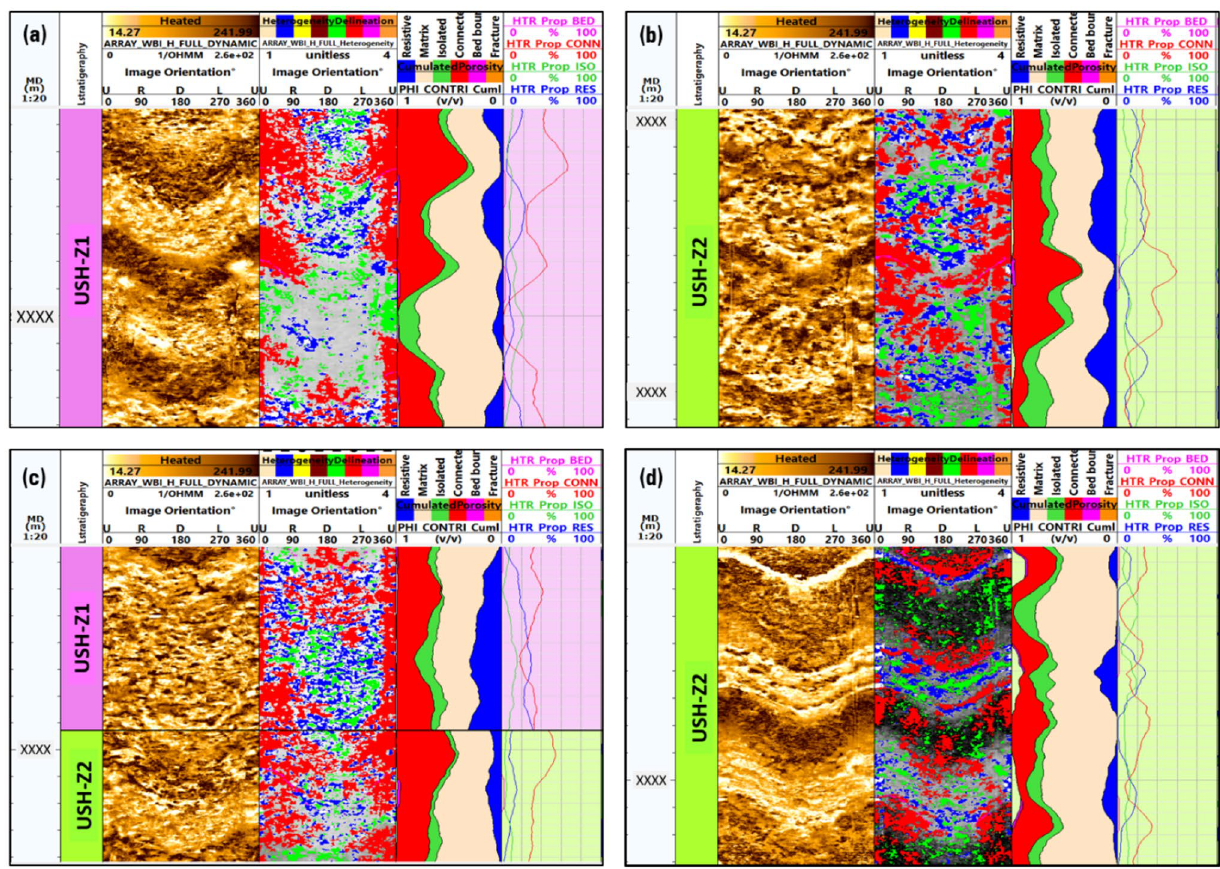
Fig. 17 Heterogeneity results for well #4 and four distinguished